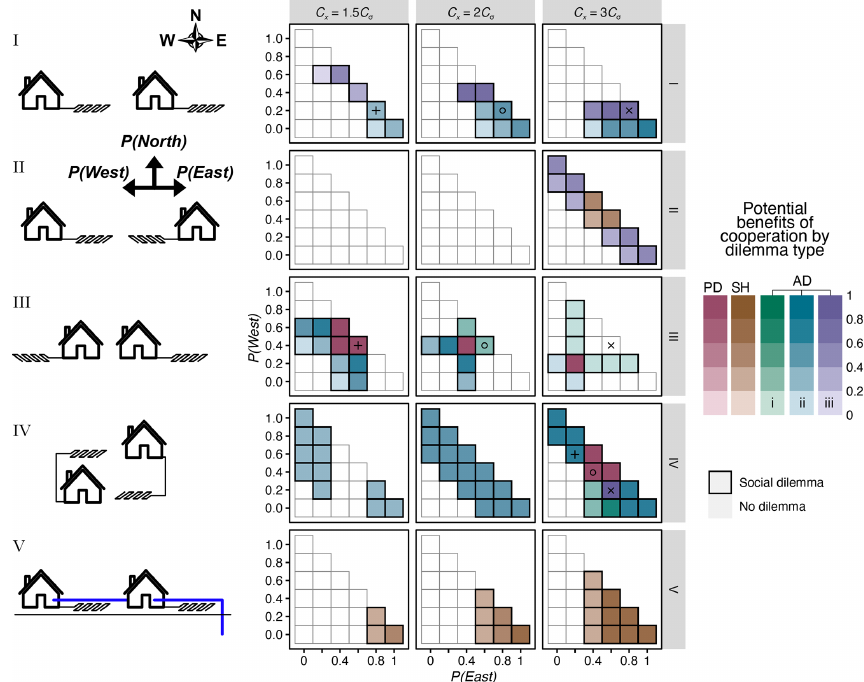
Figure 3. Social dilemmas under various household configurations and various cost ratios. The left column shows household configurations I– V, with uncertainty about the mean direction of groundwater flow. The right column shows the social dilemma types, including the prisoner’s dilemma (PD), stag hunt game (SH), and asymmetric dilemma (AD), along with the potential benefits of cooperation, which is given as the difference in normalized payouts between the social optimum and the (least desirable) Nash equilibrium and averaged for both players. The main axes represent the probability of flow towards the west and east, respectively, with the remainder being the probability of flow towards the north (i.e., P( North ) = 1 − P( West ) − P( East )